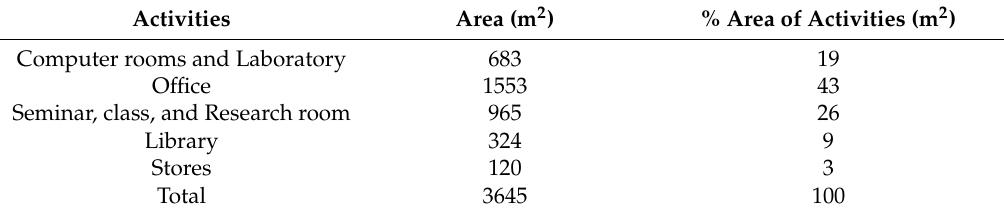
Table 5. Monthly heat demand and the percent of errors.